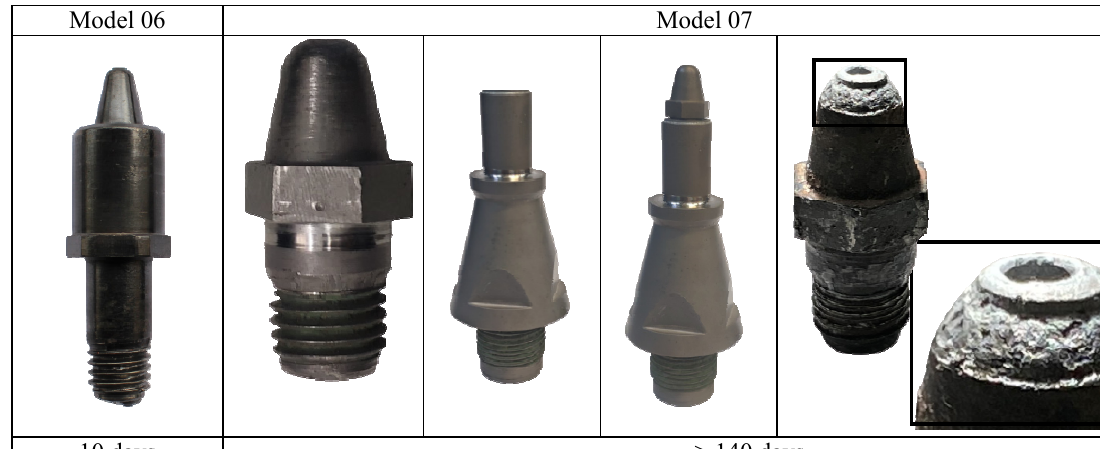
Table 4. ZIN models developed on the third stage of development.